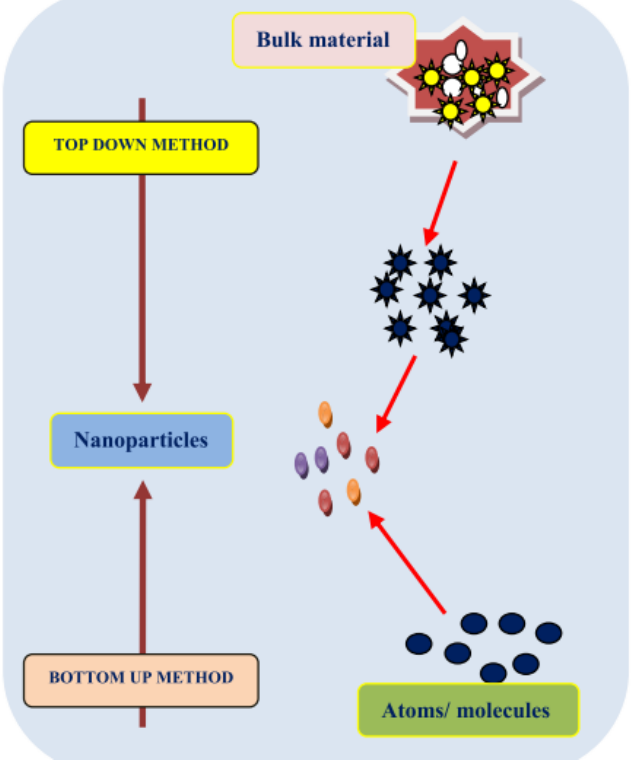
Figure 2. Top-down and bottom-up approaches to obtaining NPs. Reprinted with permission from ref. [31]. Copyright 2019 Elsevier.